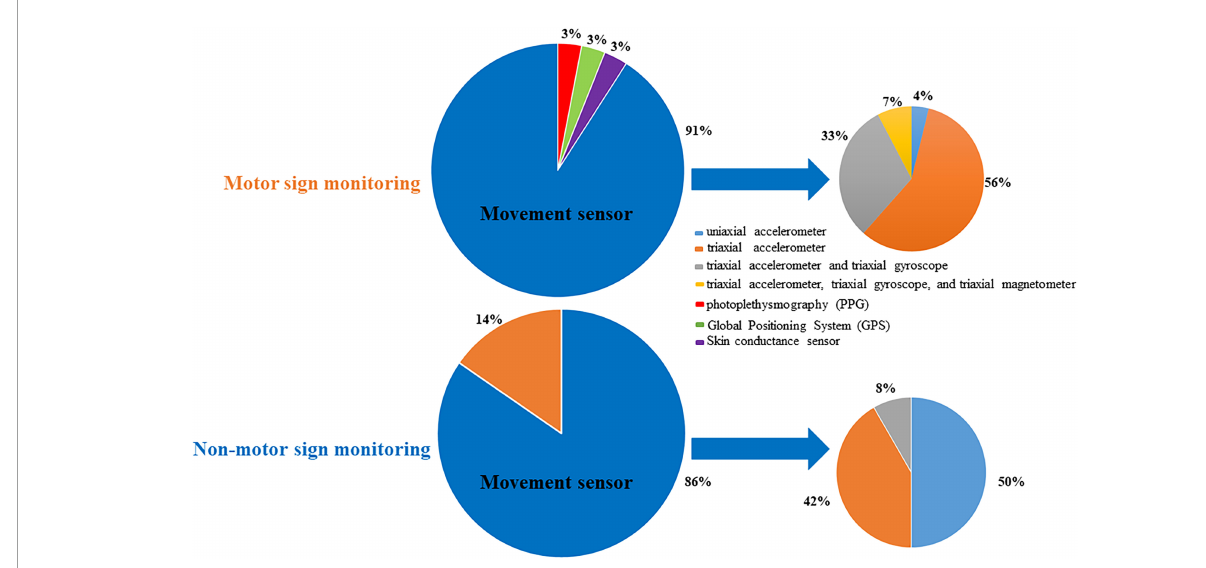
FIGURE3 Pie chart showing the percentage of sensor types in PD signs monitoring devices.